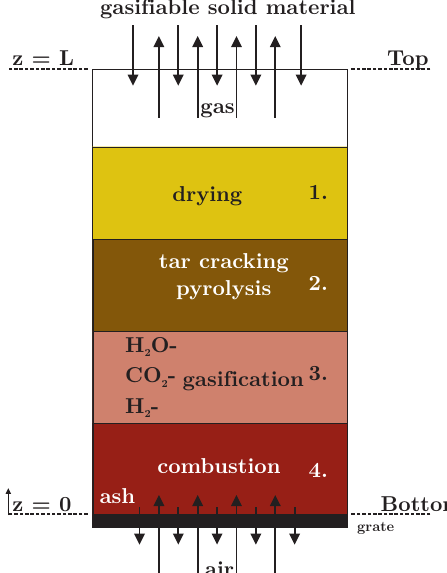
Figure 1. Counter-current gasification of solid material